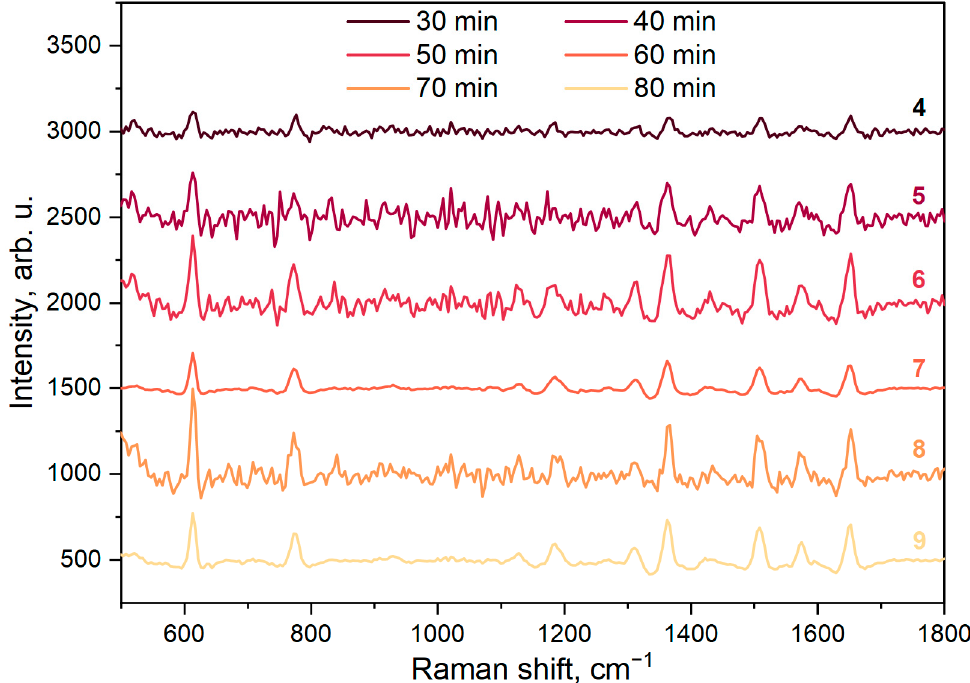
Figure 11. SERS spectra for 10 − 6 M R6G on the gold-coated macro-PS substrates.